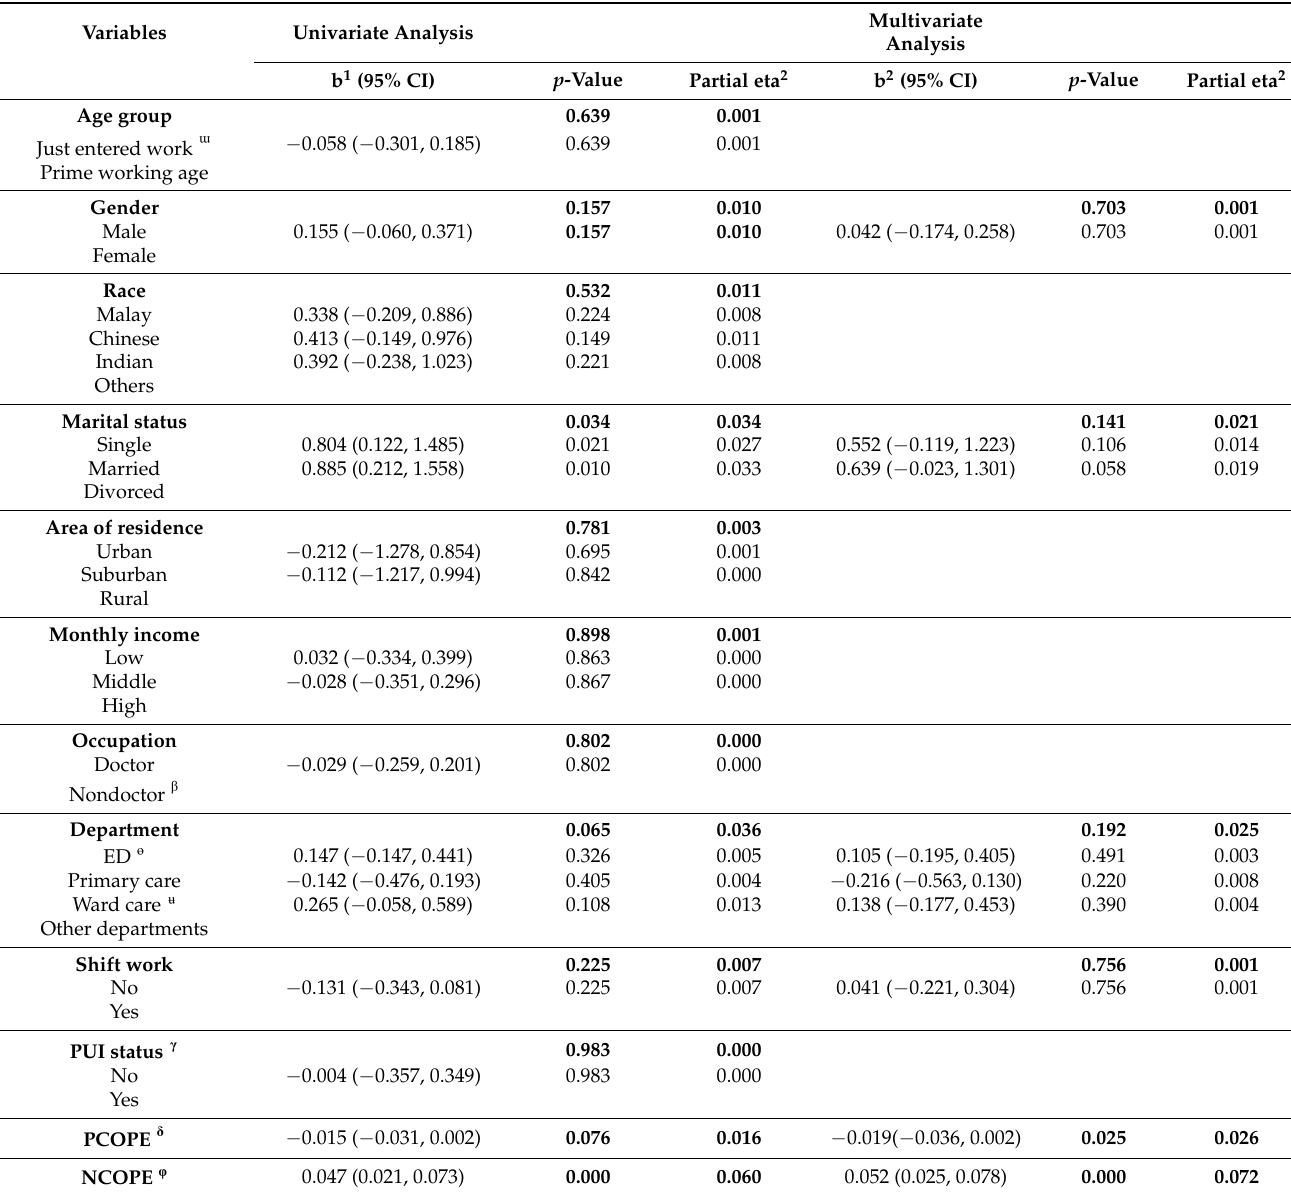
Table 9. GLM on covariates associated with transformed depression ( n =